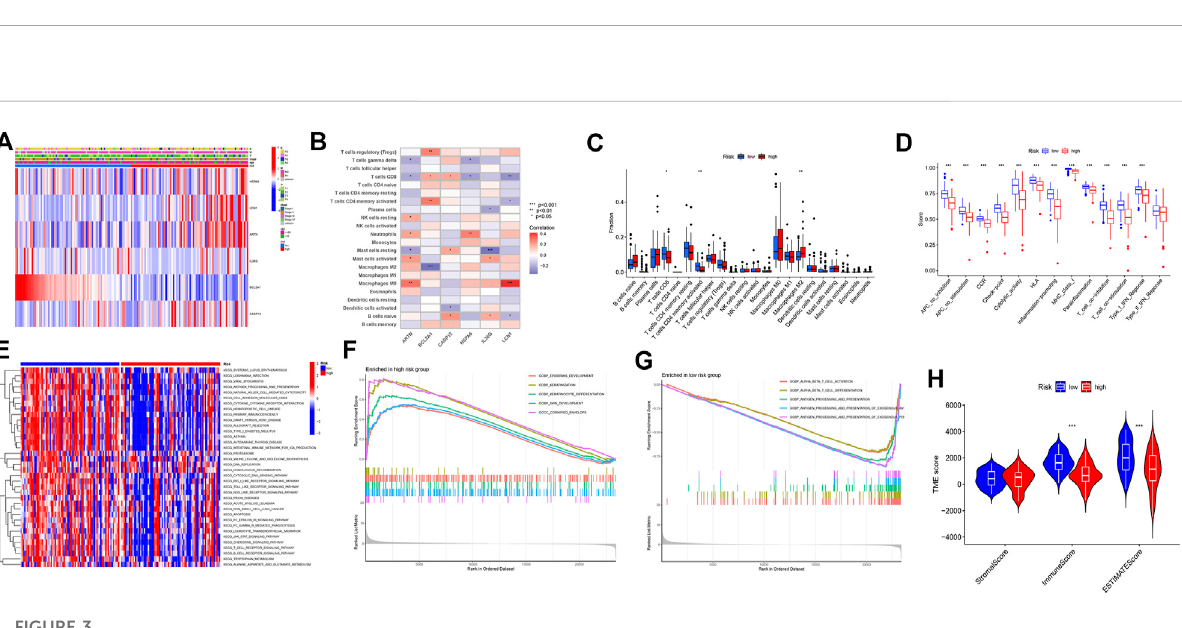
FIGURE 2 Validation of prognostic risk scoring model. (A) Survival analysis between high- and low-risk groups in The Cancer Genome Atlas database. (B) The1-year,3-year,and5-yearROCcurvevaluesintheTCGAdatabase. (C) SurvivalstatusofpatientswithTNBC(high-riskgroup:rightofdottedline; low-risk group: left of dotted line); survival status scatter plots (The state of death: red dots; The state of survival: green dots). (D,E) Principal component analysis vs t-distributed stochastic neighbor embedding analysis to verify the grouping effectiveness of the risk scores. (F) Survival analysis of the Gene Expression Omnibus (GEO) database. (G) ROC curve in the GEO database.